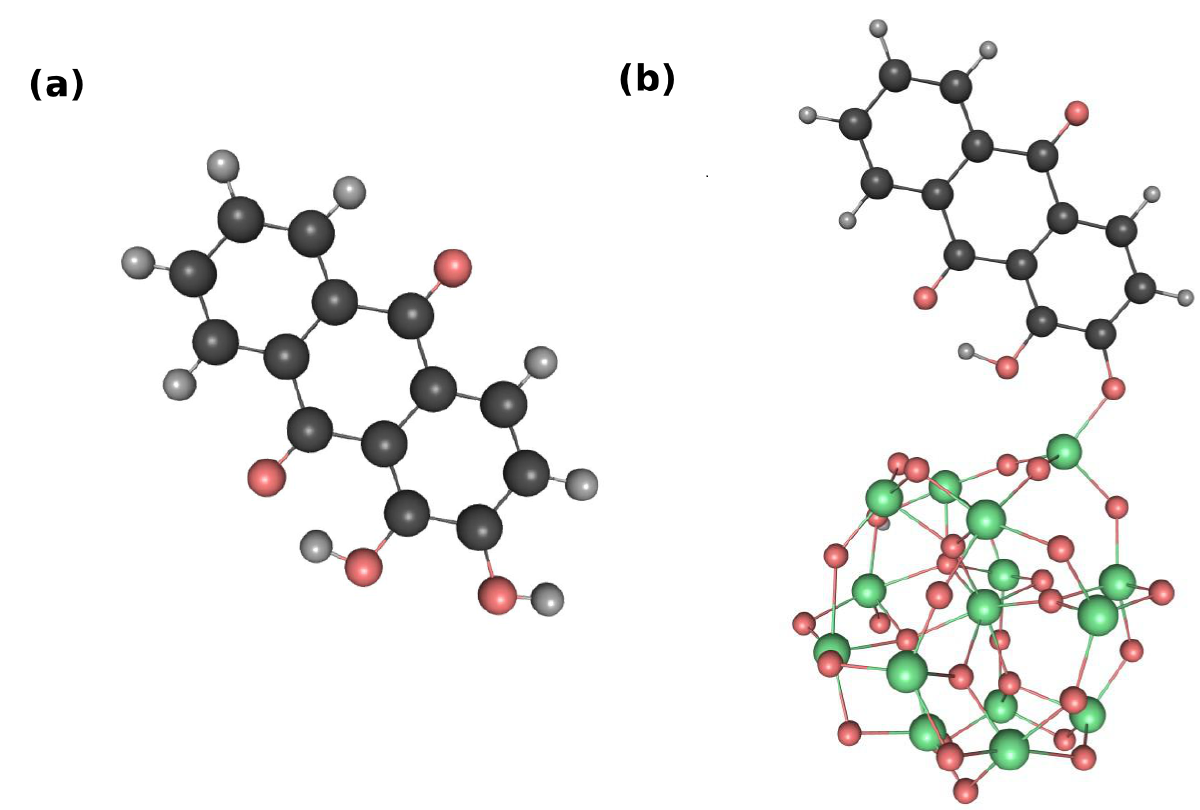
Figure 1. Optimized molecular structure of ( a ) the isolated alizarin dye, ( b ) the alizarin-(TiO ) complex. The red, green, black, and grey beads represent oxygen, titanium, 2 15 carbon, and hydrogen atoms,